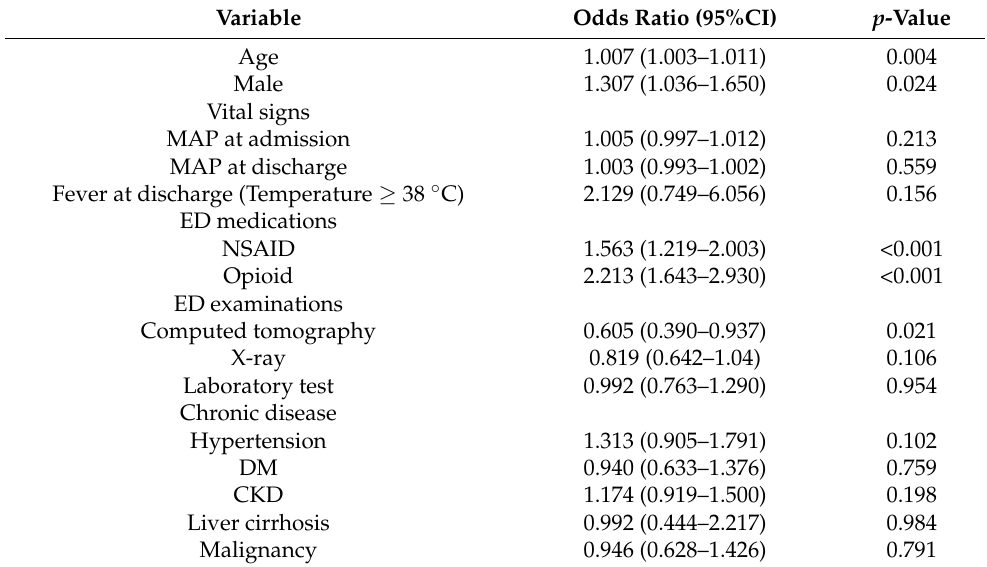
Table 2. Logistic regression analysis of clinical characteristic associated with return